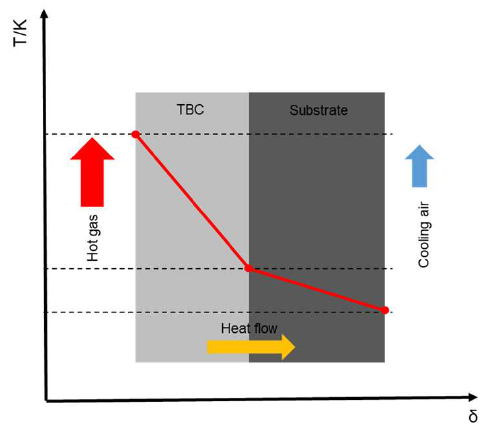
Figure 3. The temperature distribution of a blade wall. The Newton cooling formula, Fourier’s law, and Stephen Boltzmann’s Law are used to describe convection heat transfer, heat conduction, and radiation heat transfer, respectively